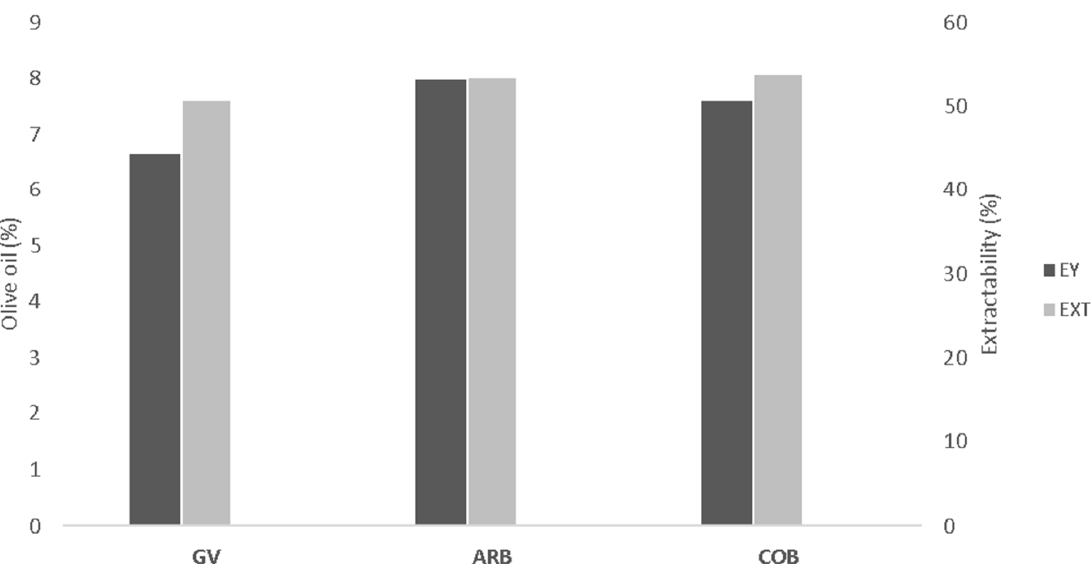
Figure 1. Olive oil extraction yield (EY, dark grey) to be read at the left axis. Olive oil extractability (EXT, bright grey), to be read at the right axis. Olive cultivars: ‘Galega vulgar’ (GV), ‘Arbequina’ (ARB) and ‘Cobrançosa’ (COB).